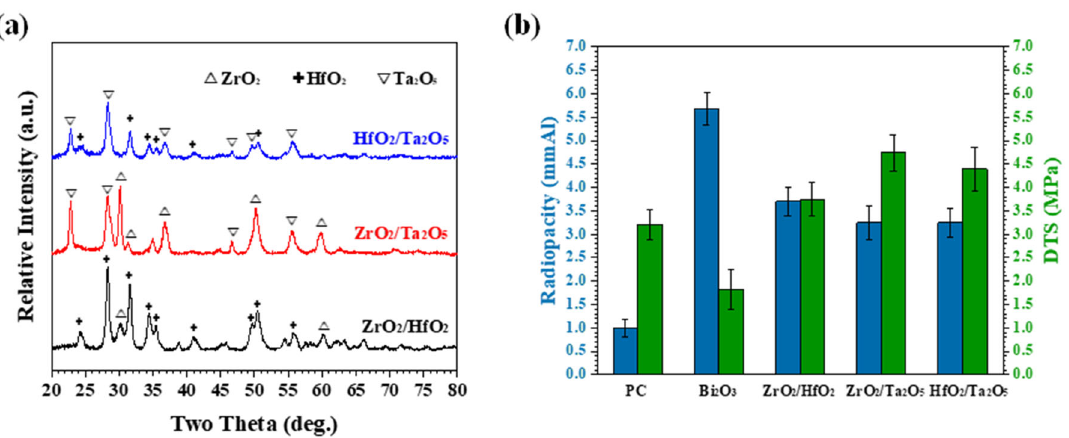
Figure 7. ( a ) X-ray diffraction patterns of as-milled binary oxide powder and ( b ) the radiopacities and DTS and MTA-like cements prepared by binary oxide powder. PC and Bi 2 O 3 -MTA are shown for comparison.